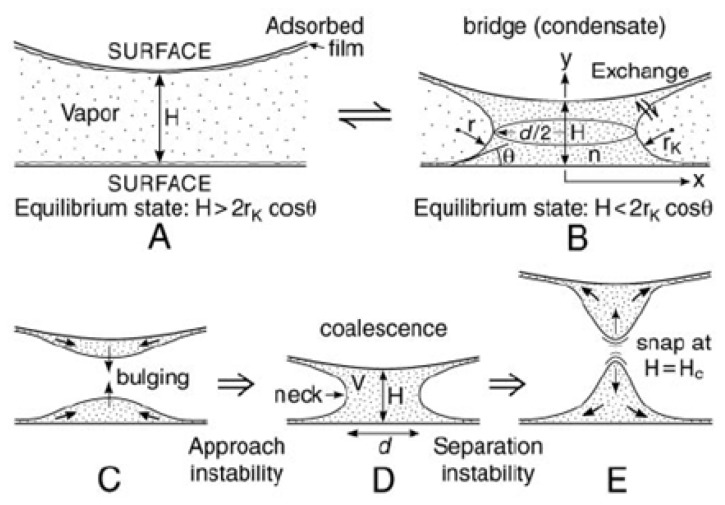
Liquid bridges between two surfaces (A and B). The equilibrium state of a liquid bridge is determined by thermodynamics. At equilibrium, the mean curvature of the liquid vapor interface of a bridge must equal the Kelvin radius rk. For wide necks and small θ, d >> r so that r ≈ rk, as drawn; (C–E) Transitions between the equilibrium states A and B usually occur via nonequilibrium processes. For example, because of the vdW force on approach or a Rayleigh instability on separation, fast mechanical instabilities may trigger bridge coalescence (C→D) or snapping (D→E). In such processes, the meniscus curvature is not determined by the Kelvin equation [245].